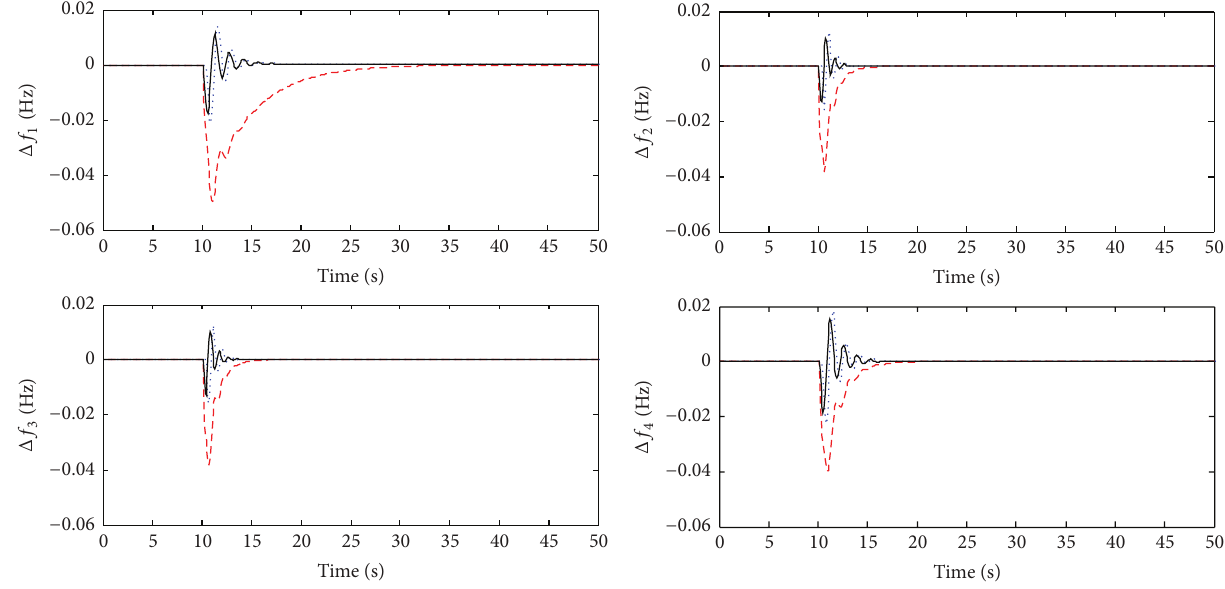
Figure 11: Response of frequency deviation to step load disturbance in Case 2: distributed MPC (solid line), centralized MPC (dotted line), and decentralized MPC (dashed line).